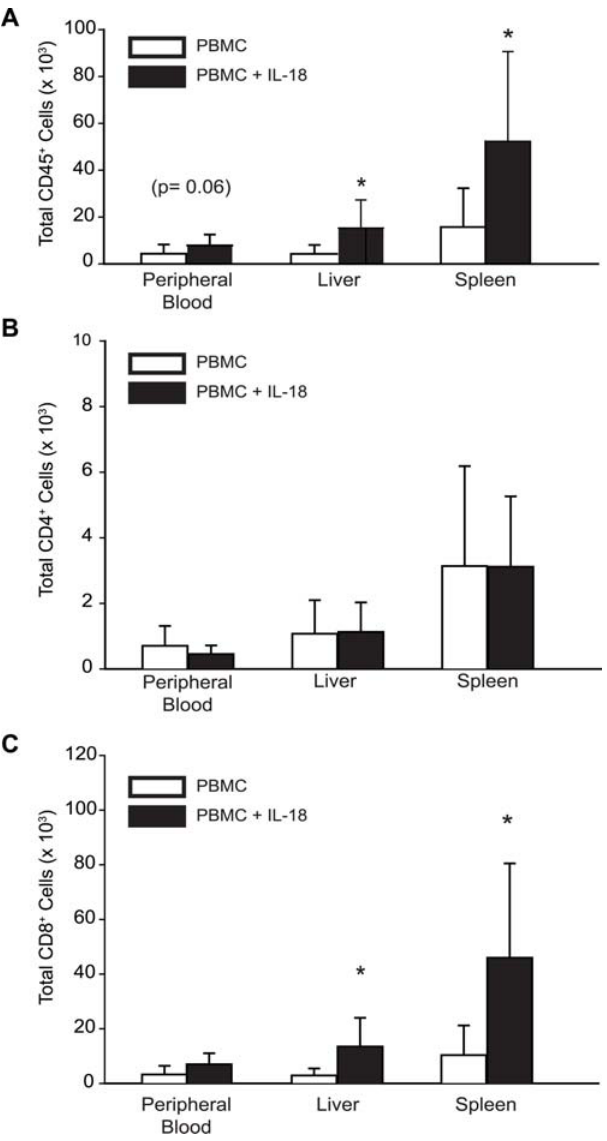
Figure 1. Human IL-18 Promotes Systemic Increases in Human CD8 T Cell Numbers in NOD/ scid/ b 2 m null mice injected with human PBMCs. NOD/ scid / b 2 m null mice were injected intraperitoneally with 5 6 10 7 human PBMCs and 24 hours later, a three week course of daily subcutaneous injections of 15 m g recombinant human IL-18 was initiated. At the end of the injection time course, the animals were sacrificed, peripheral blood was collected, and liver and spleen homogenates were prepared. Human cell populations were detected by flow cytometry. Absolute cell numbers in the peripheral blood were determined using Tru-Count tubes; absolute cell numbers from spleen and liver were determined using a Coulter Multisizer 3. The mean 6 s.d. is shown for (A) human CD45 + cells, (B) human CD4 + cells, and (C) human CD8 + cells. Open bars represent values from mock-treated animals; filled bars represent values from IL-18 treated animals. These data are a representative single experiment of seven different experiments. Asterisks indicate significant differences between mock- and IL-18-treated animals (n=6 to 10 mice/group; p , 0.05).